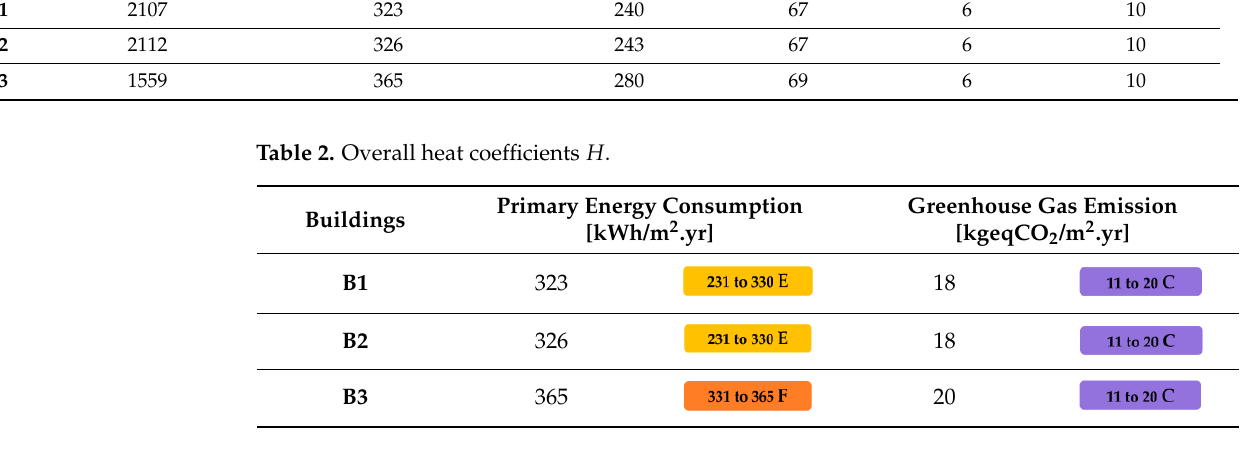
Table 3. Overall heat coefficients H Table 3. Overall heat coefficients 𝐻 . Table 3. Overall heat coefficients 𝐻 . Table 3. Overall heat coefficients 𝐻 . Table 3. Overall heat coefficients 𝐻 . Table 3. Overall heat coefficients 𝐻 . Table 3. Overall heat coefficients 𝐻 .